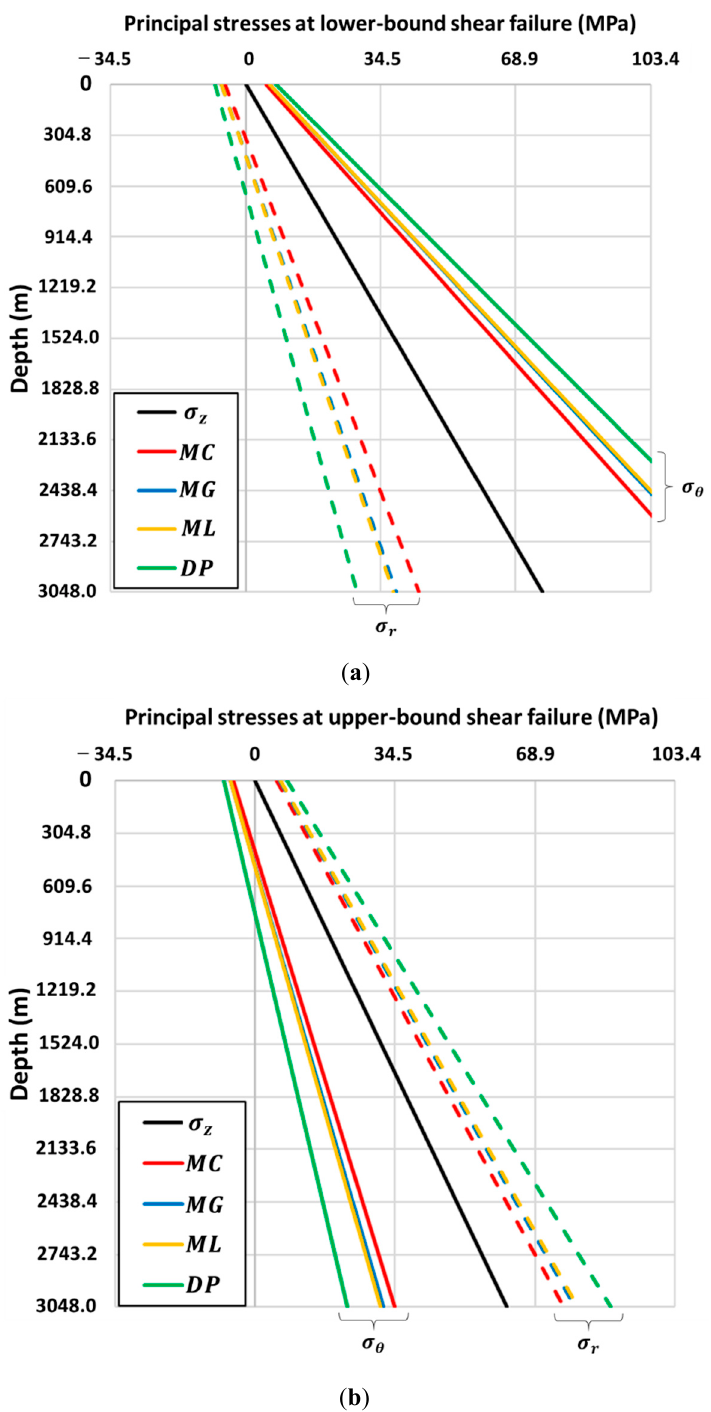
Figure 5. Strike-slip regime—strike-slip basin. Locally induced principal stresses at a moment of ( a ) lower-bound and ( b ) upper-bound shear failure under the strike-slip regime with the vertical, maximum and minimum horizontal stresses of 22.6, 24.9, and 20.4 kPa / m, respectively. The black solid lines represent the axial stress ( σ z ) . The tangential ( σ θ ; solid) and radial ( σ r ; dashed) stresses are calculated by the Mohr–Coulomb (MC; red), Mogi–Coulomb (MG; blue), modified Lade (ML; yellow), and Drucker–Prager (DP; green) failure criteria.